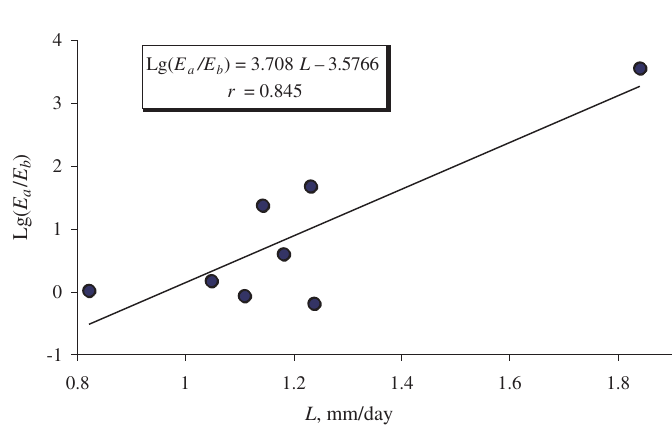
Fig. 10. Averaged annual values of E a / E b being the ratio of total seismic energy of earthquakes of the North Tien Shan and adjacent areas occurring 5 days after and 5 days before MHD-generator start-ups in the upper 5 km layer plotted as function of average annual level of atmospheric precipitation L in Bishkek site (dots) and fit- ted line. The values E a / E b are plotted on a logarithmic scale.